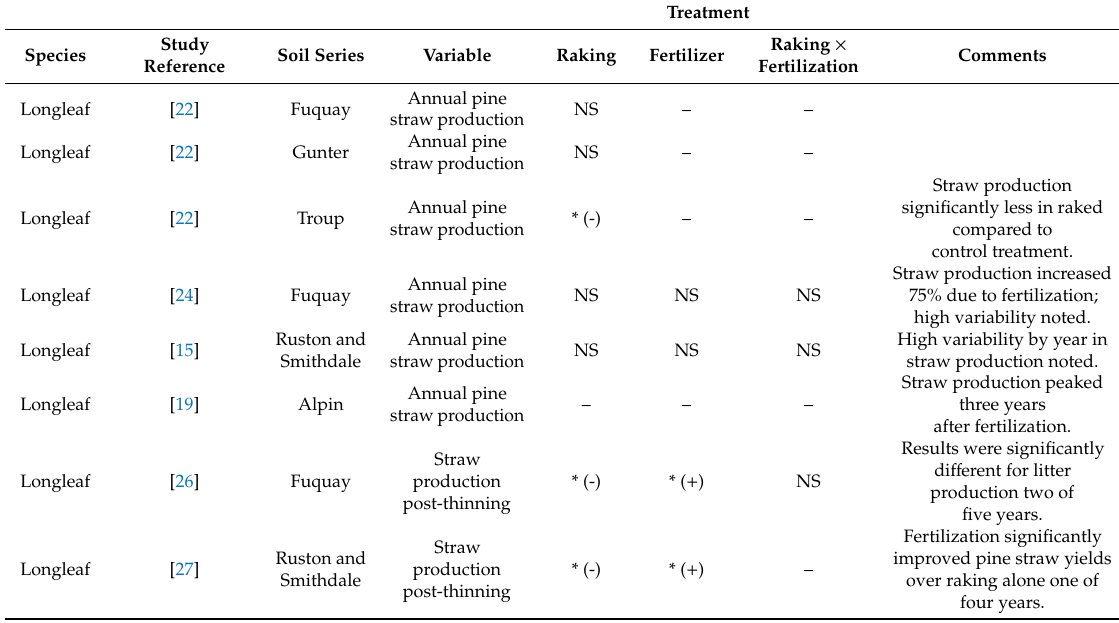
Table 4. Summarization of statistically significant longleaf pine straw and litter production results by treatment, soil series, and study. Non-significant (NS), ‘* (-)’ and ‘* ( + )’ indicate either a negative or positive response associated with significant variables (*), and ‘—’ indicates that a statistical test was not reported for that variable and treatment